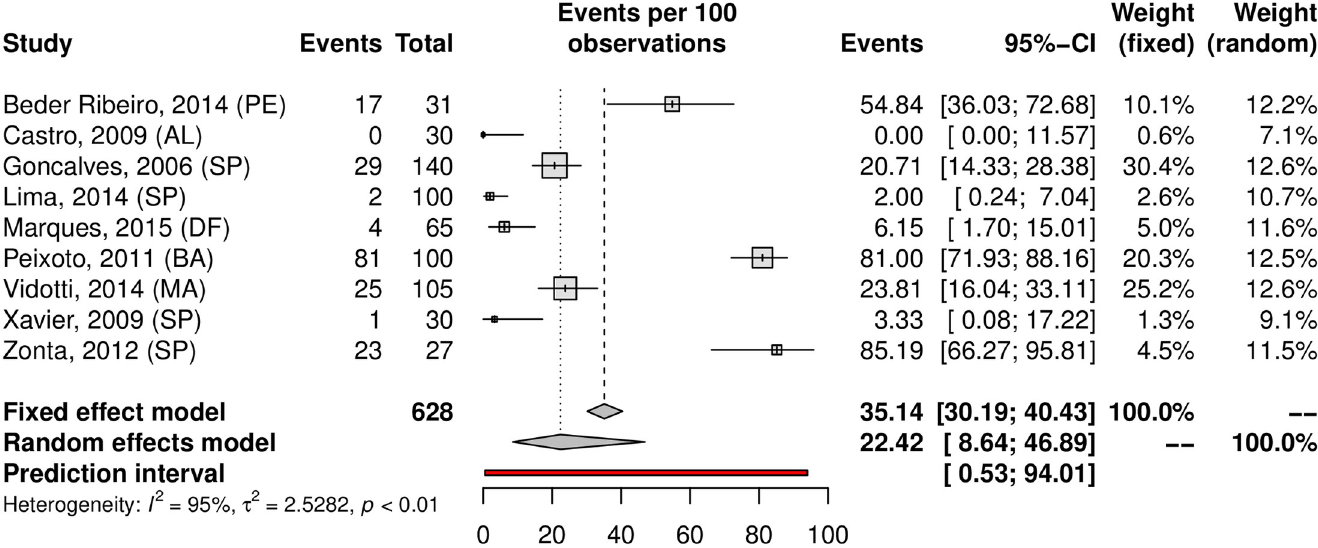
PLOS ONE | https://doi.org/10.1371/journal.pone.0229154 February 21,